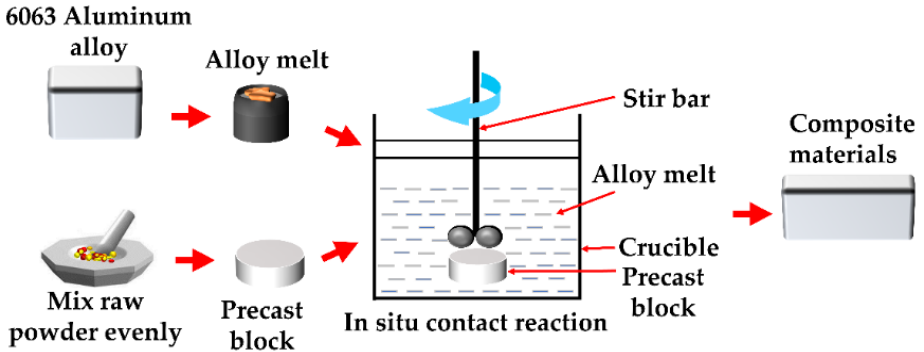
Figure 2. The in situ reaction and near ‐ liquid ‐ phase line ‐ casting method for the composite ‐ material preparation process.